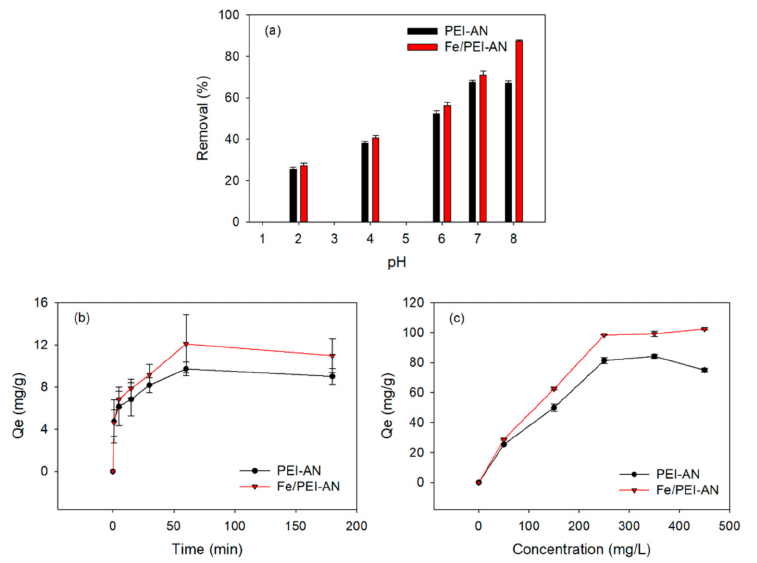
Figure 4. Effect of different conditions on Ni 2 + adsorption for composite nanofiber adsorbents: ( a ) pH, ( b ) time, and ( c ) initial